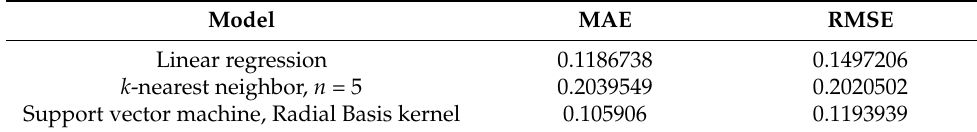
Table 2. Results of weak predictors.